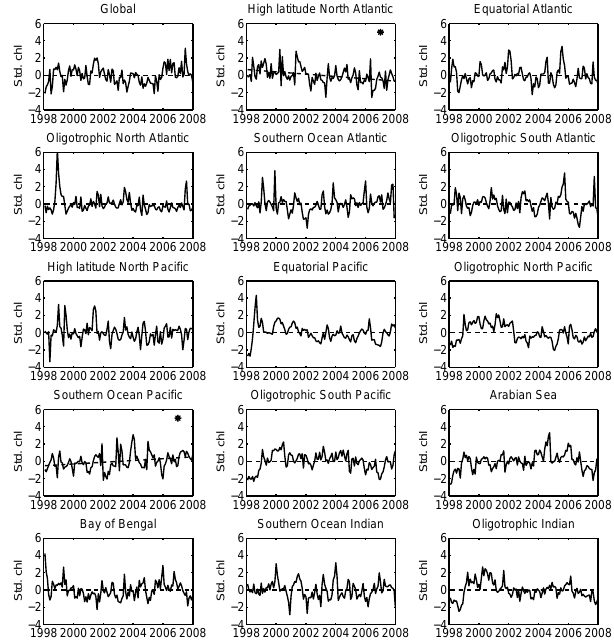
Fig. 2. Deseasonalized anomalies in SeaWiFS ocean chloro- phyll concentrations from 1998–2007 averaged globally and in 14 biomes. Since the magnitude and variability varies among the different regions, the chlorophyll concentrations are standardized (the mean is subtracted from the time series and then the time series is divided by its standard deviation) to display on the same scale. The dotted lines represent the trends. The two panels with a star represent the trends that are significantly different from